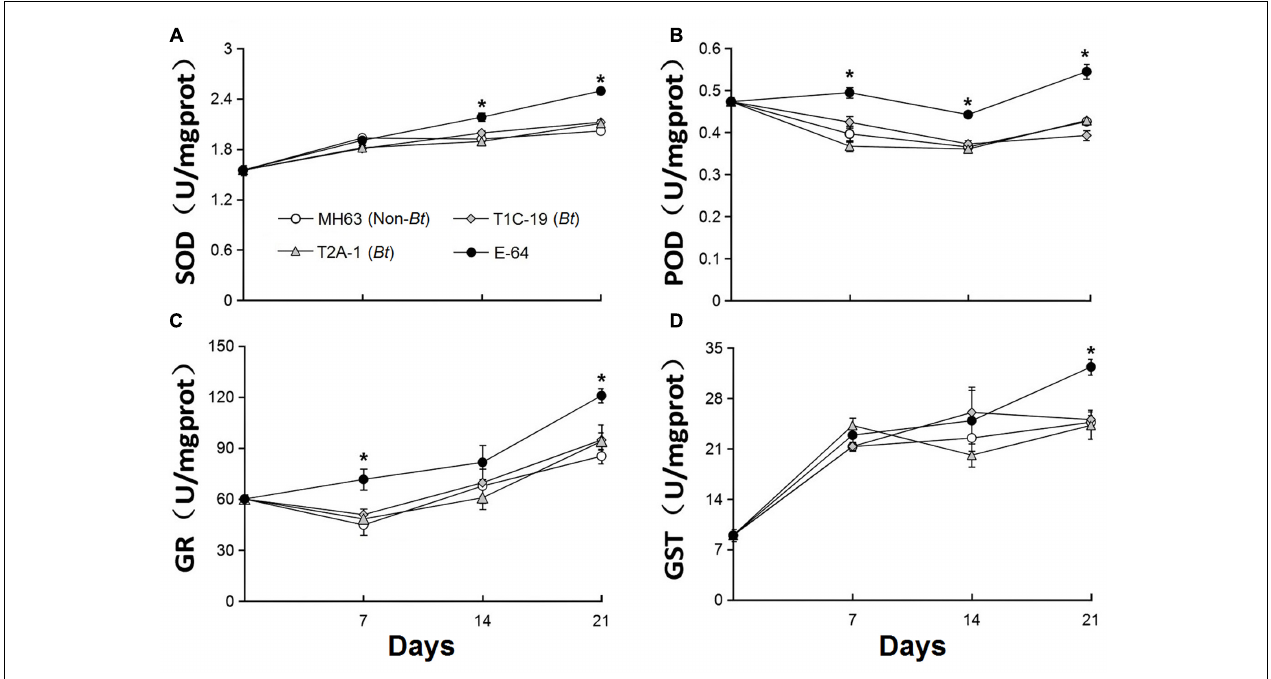
FIGURE 3 | Enzyme activities ( A : peroxidase, POD; B : superoxide dismutase, SOD; C : glutathione, GR; and D : glutathione S -transferase, GST) in F. candida that fed on a diet consisting of non- Bt rice pollen (MH63, negative control), Bt rice pollen containing Cry1C or Cry2A (T1C-19 or T2A-1), or non- Bt rice pollen containing E-64 protein (positive control) for 35 days. Values are means ± SE, n = 4. Asterisks indicate a significant difference between the treatment and the negative control (MH63) ( P <